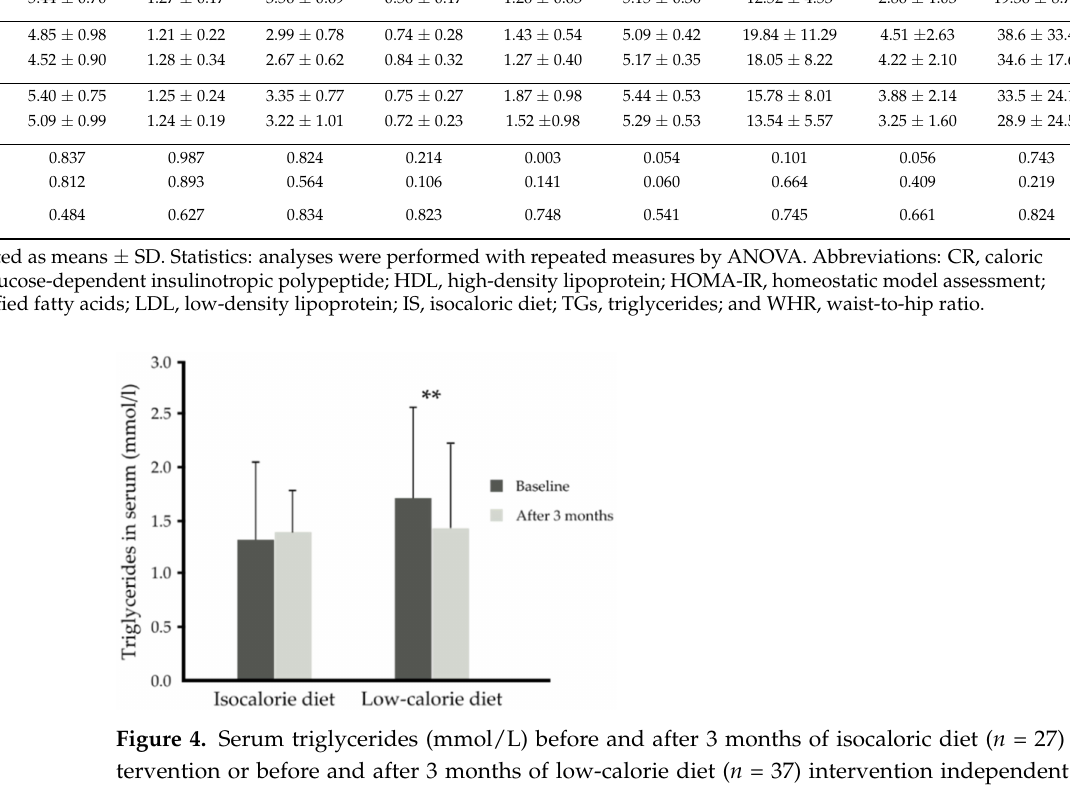
Figure 4. Serum triglycerides (mmol/L) before and after 3 months of isocaloric diet ( n = 27) in- tervention or before and after 3 months of low-calorie diet ( n = 37) intervention independent of supplementation. Data are shown as mean ± SD. Significance: ** p < 0.01 after versus before low-calorie